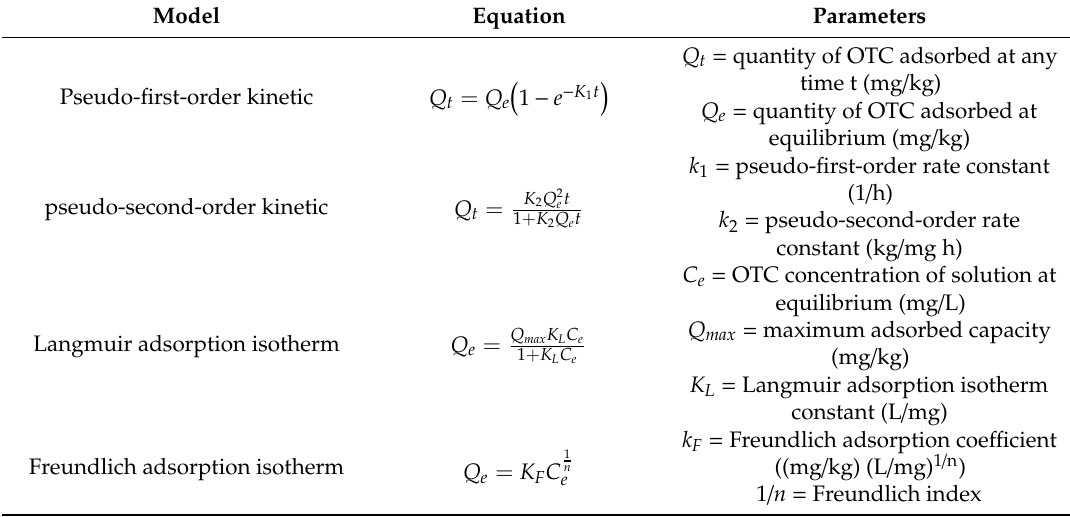
Table 2. The equations of adsorption models of kinetics and